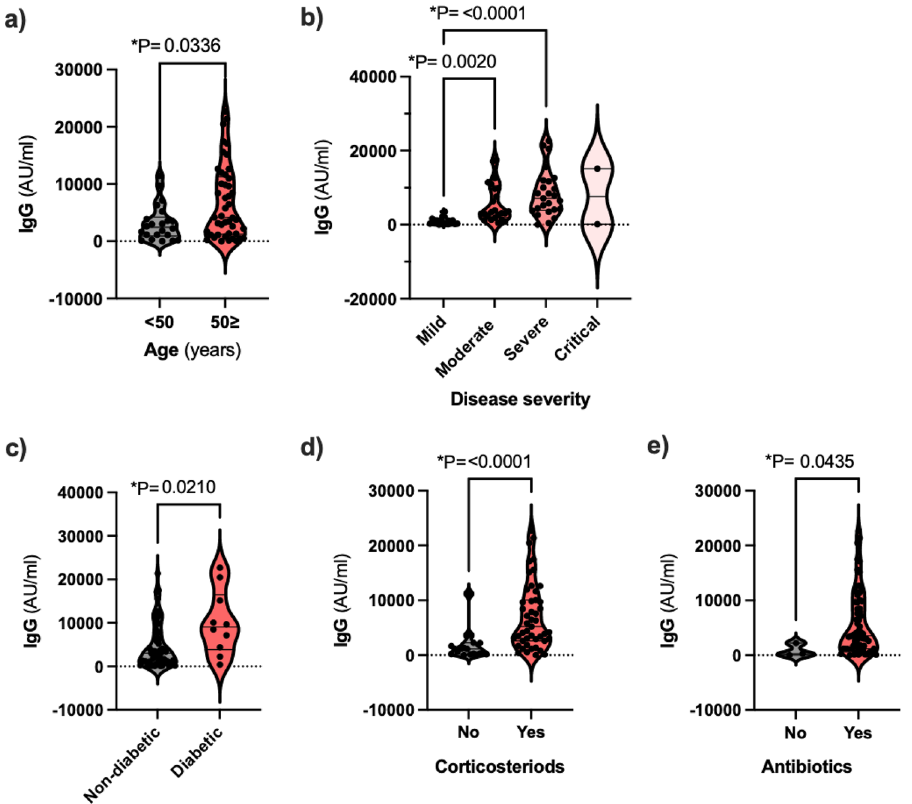
Figure 1. Distribution of anti‑SARS‑CoV‑2 IgG across age groups, disease severity groups, patients with and without diabetes, corticosteroid and antibiotic administration. Levels of IgG were significantly higher in age group > 50, severe and critical patients, in diabetics and patients treated with corticosteroids and antibiotics.